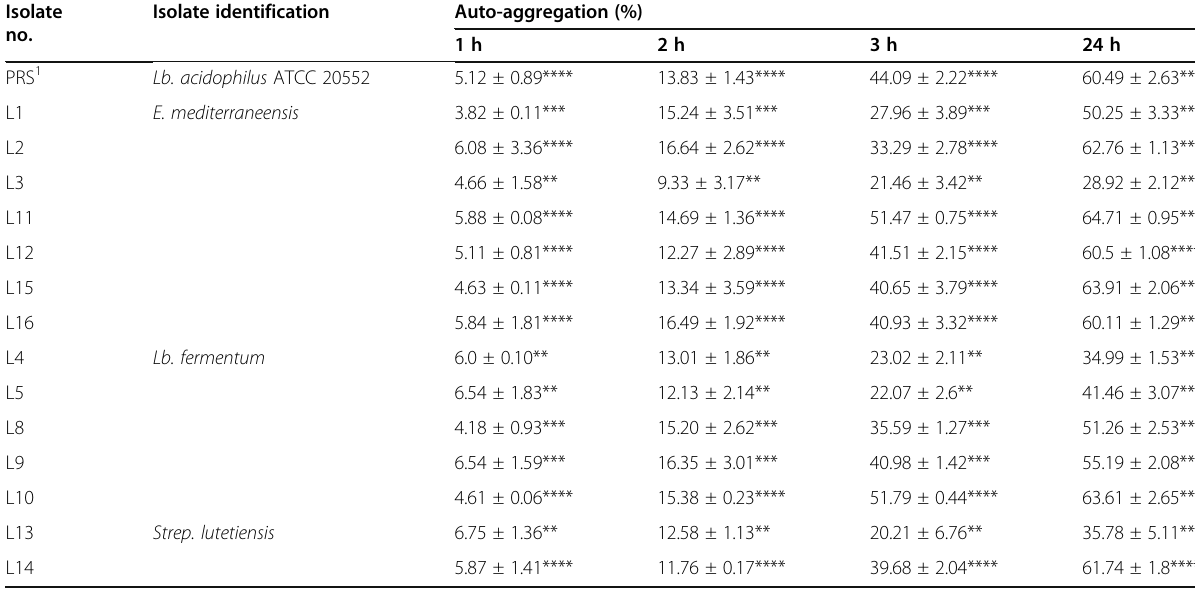
1: probiotic reference strain. Data are expressed as mean ± SD (standard deviation). * P values were ˂ 0.05.